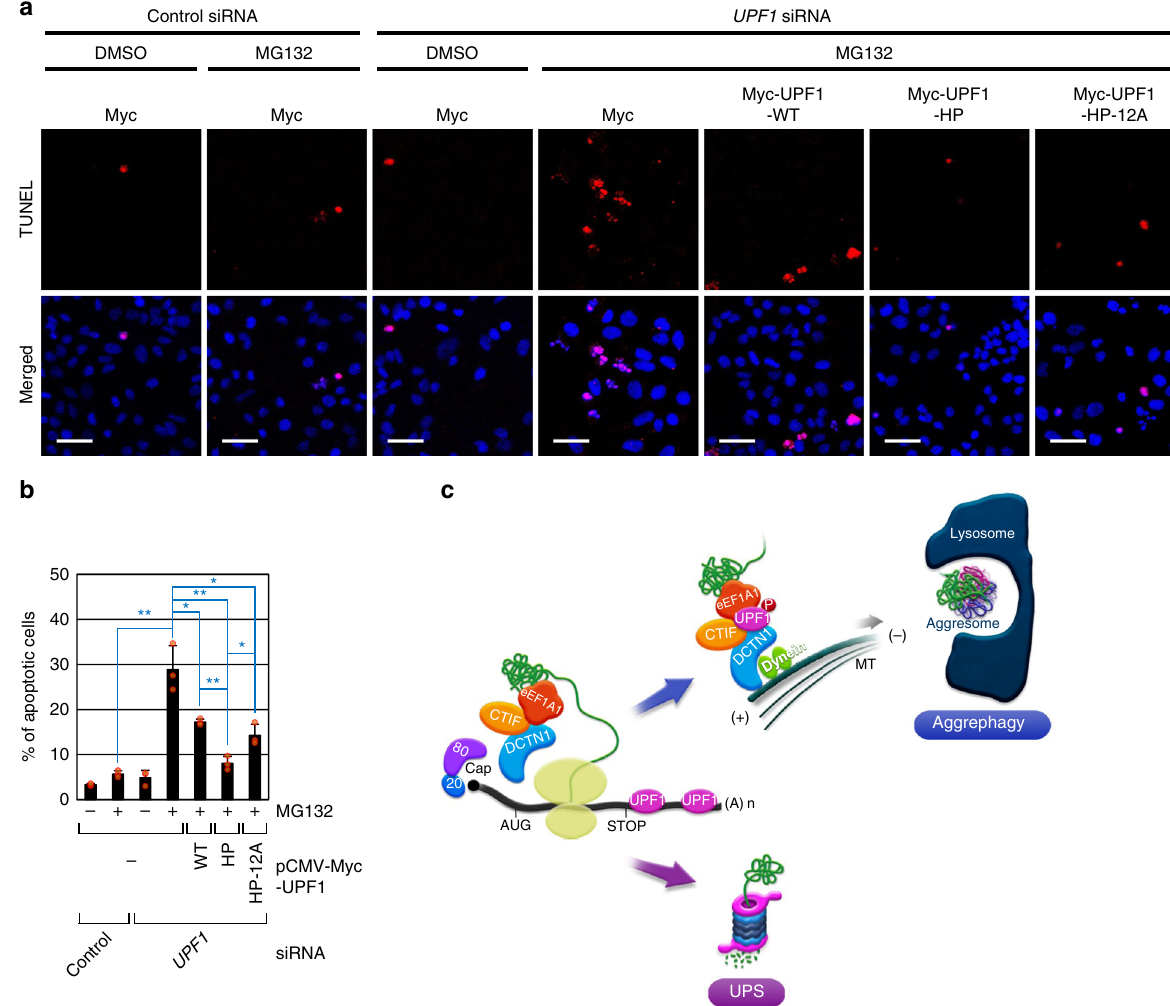
Fig. 7 UPF1 hyperphosphorylation represses apoptosis induced by proteotoxic stresses. a , b The in fl uence of UPF1 hyperphosphorylation on the apoptosis induced by proteotoxic stresses. Stably CFTR- Δ F508 – expressing HeLa cells either depleted or not depleted of endogenous UPF1 were retransfected with a plasmid expressing Myc-UPF1-WT or one of its variants. One day after transfection, the cells were treated with either DMSO or MG132 for 16 h. a The population of apoptotic cells was visualized by TUNEL assay. Scale bar, 50 μ m; n = 3. b TUNEL-positive cells were quantitated, and the relative percentage of apoptotic cells is presented. Data are presented as mean values ± SD. Two-tailed, equal-sample variance Student ’ s t test was carried out to calculate the P values. * P < 0.0208; ** P < 0.0027. The exact P values are provided in a Source Data File; n = 3; Source data are provided as a Source Data File. c The proposed model of the role of UPF1 in aggresome